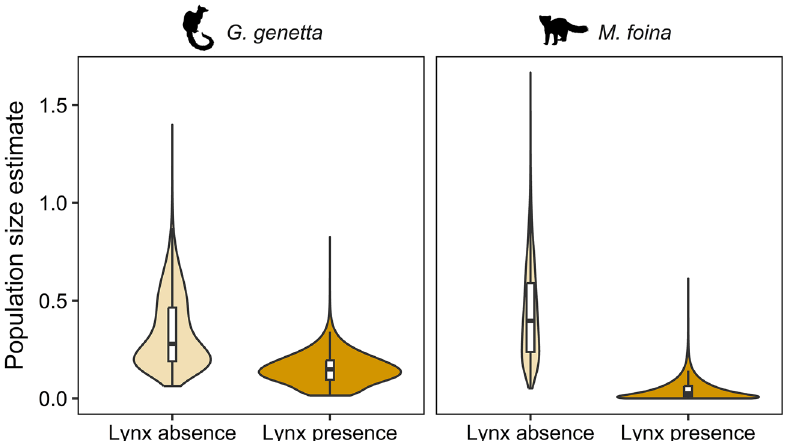
Figure 2. Estimated density (individuals per km 2 ) for the common genet ( G. genetta ) and the stone marten ( M. foina ). The width of each density curve corresponds with the frequency of data in each abundance interval and boxplots show the median and data quartiles with upper and lower whisker limits.